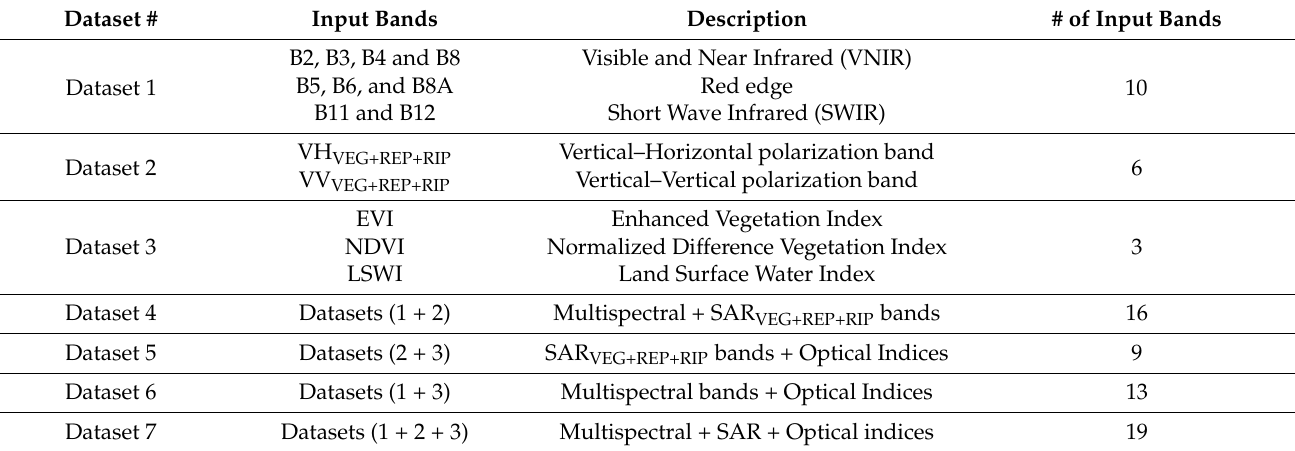
Table 2. Description of image composites used for experiments in this study (where B =